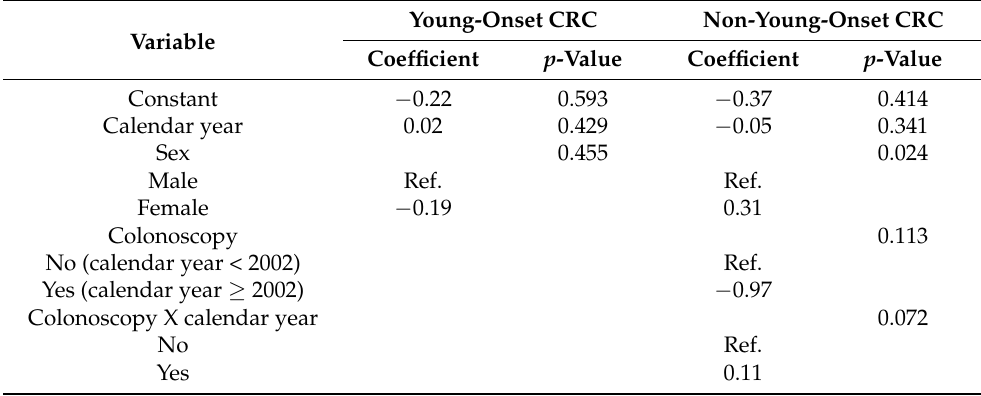
Table A3. Poisson regression for standardized incidence ratios displayed in Figure